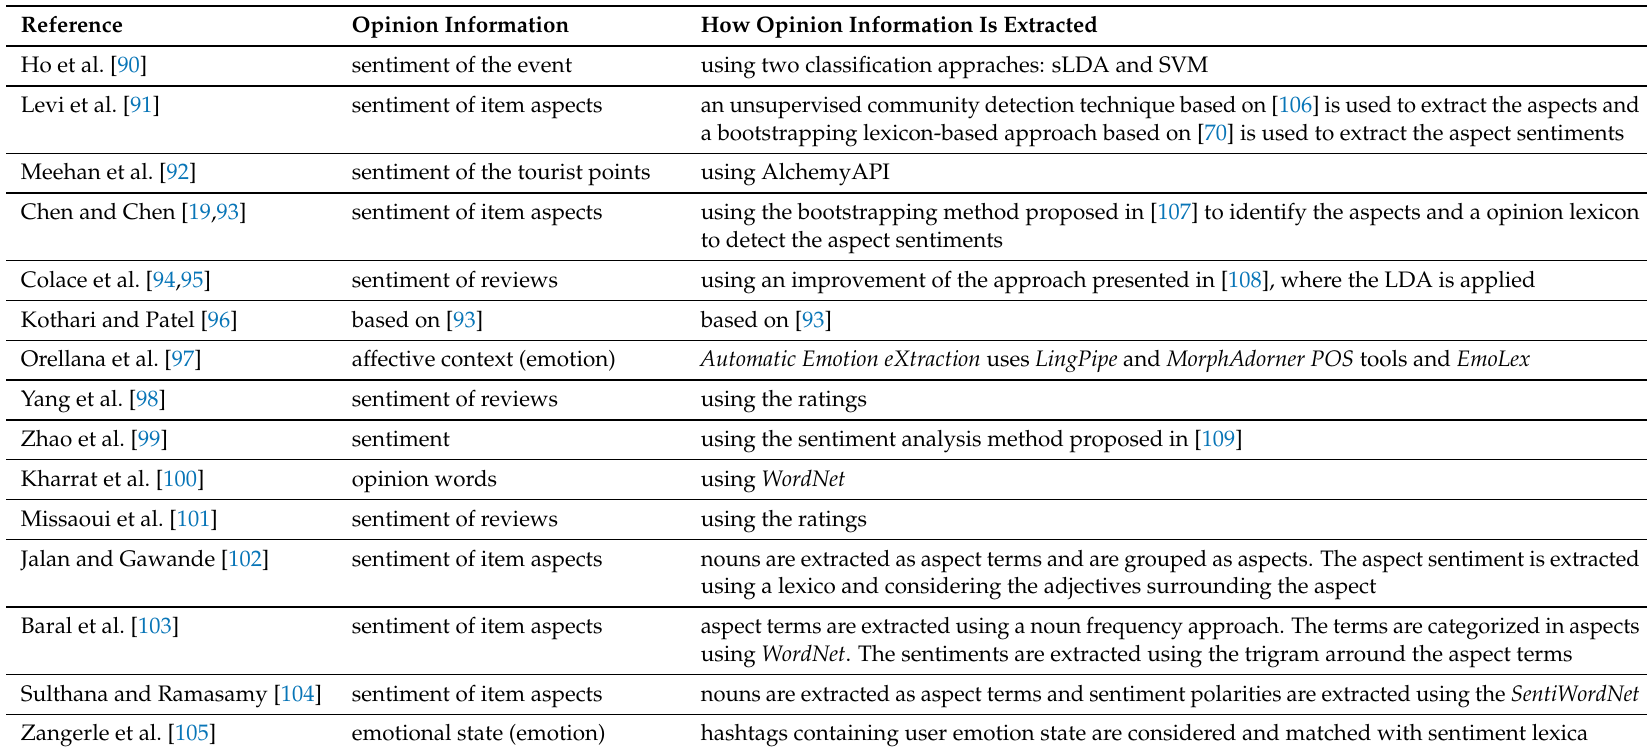
Table 3. Answers for research questions related to opinion information (questions 3 and